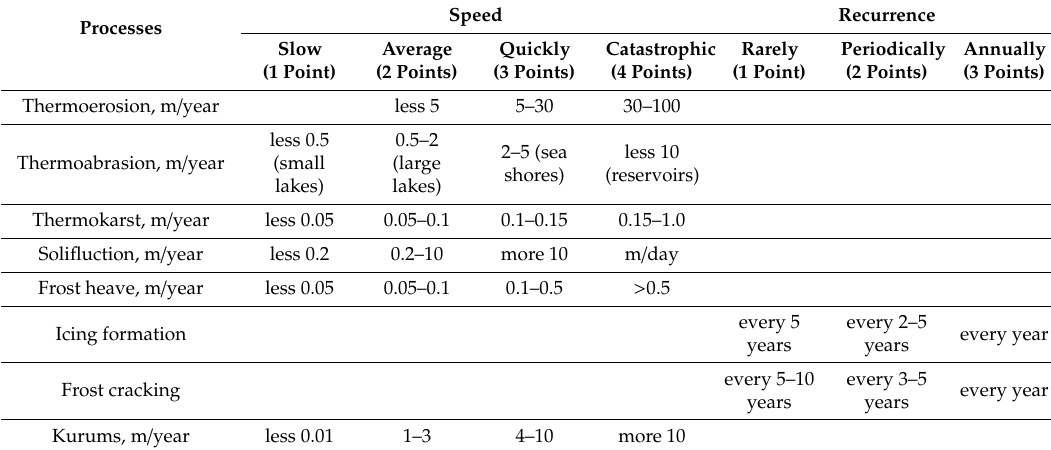
Table 2. Development rate and recurrence of cryogenic processes.